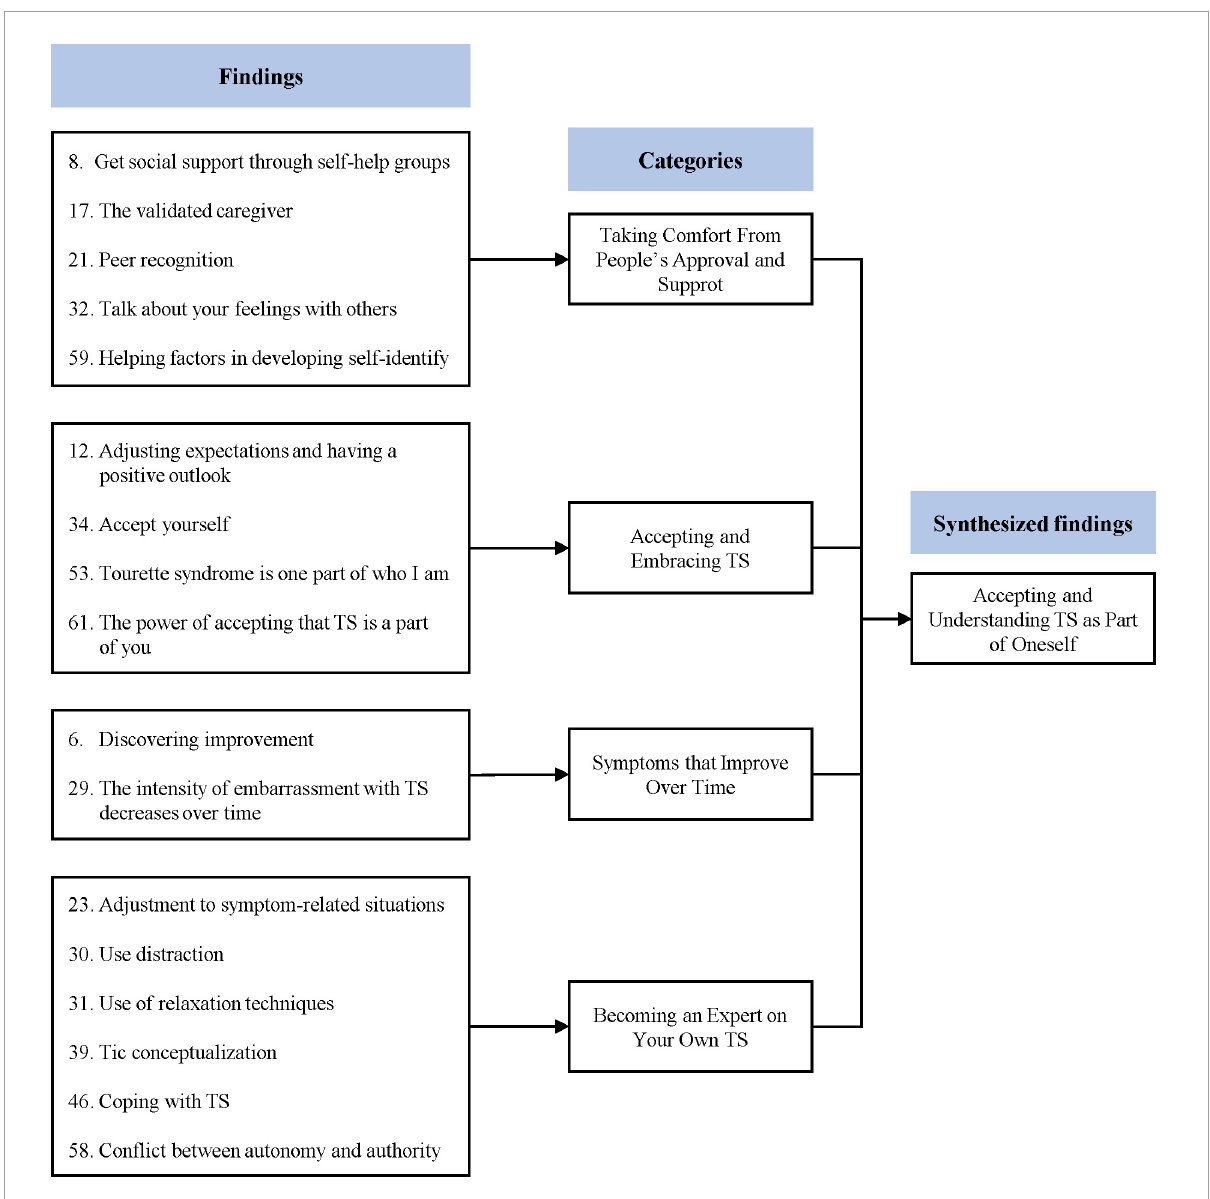
FIGURE4 Synthesized finding 3: Accepting and understanding TS as part of